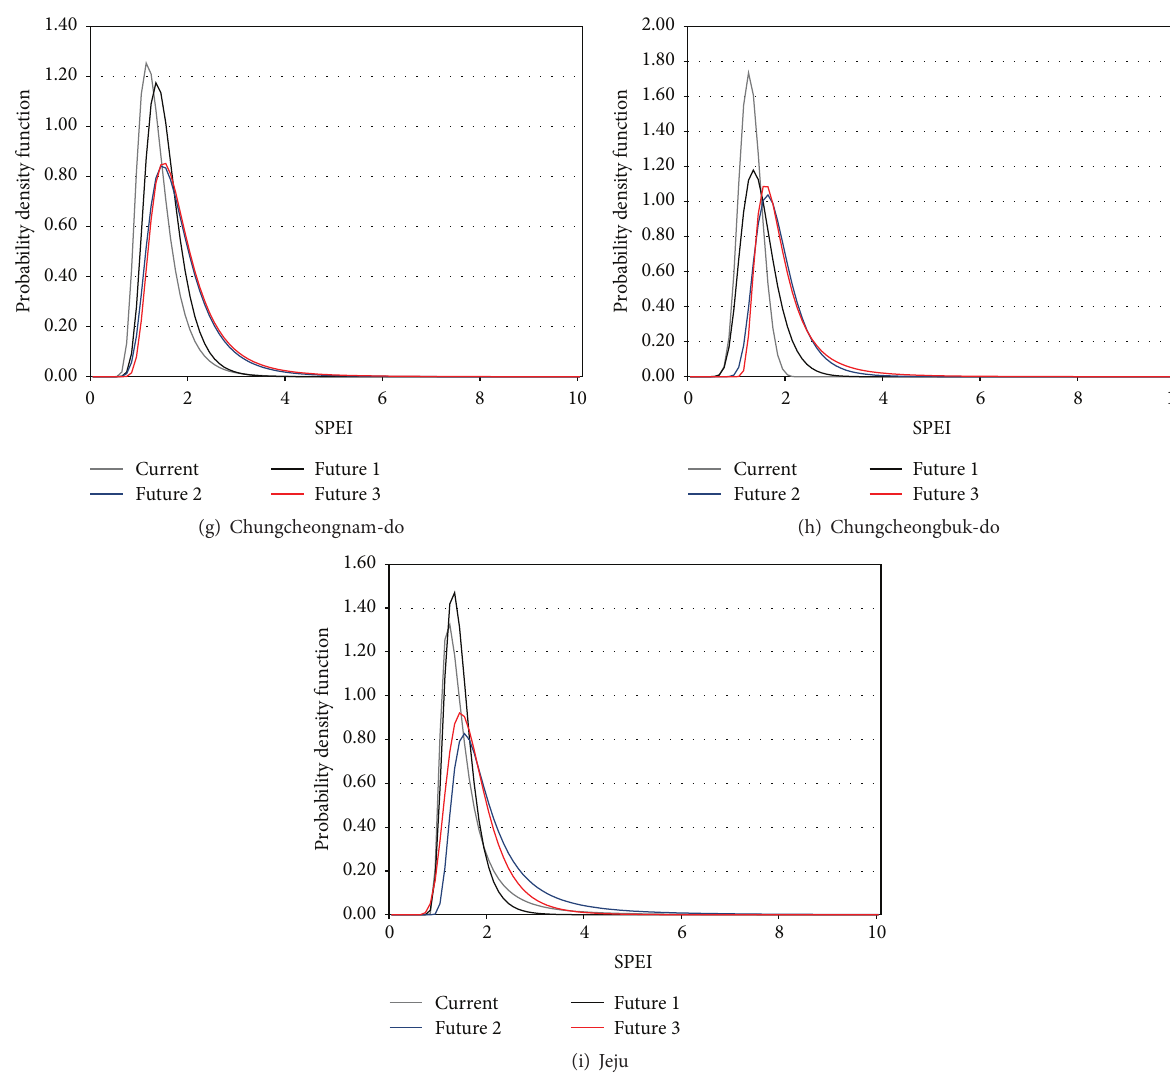
Figure 5: GEV PDF projection of maximum drought intensity according to administrative